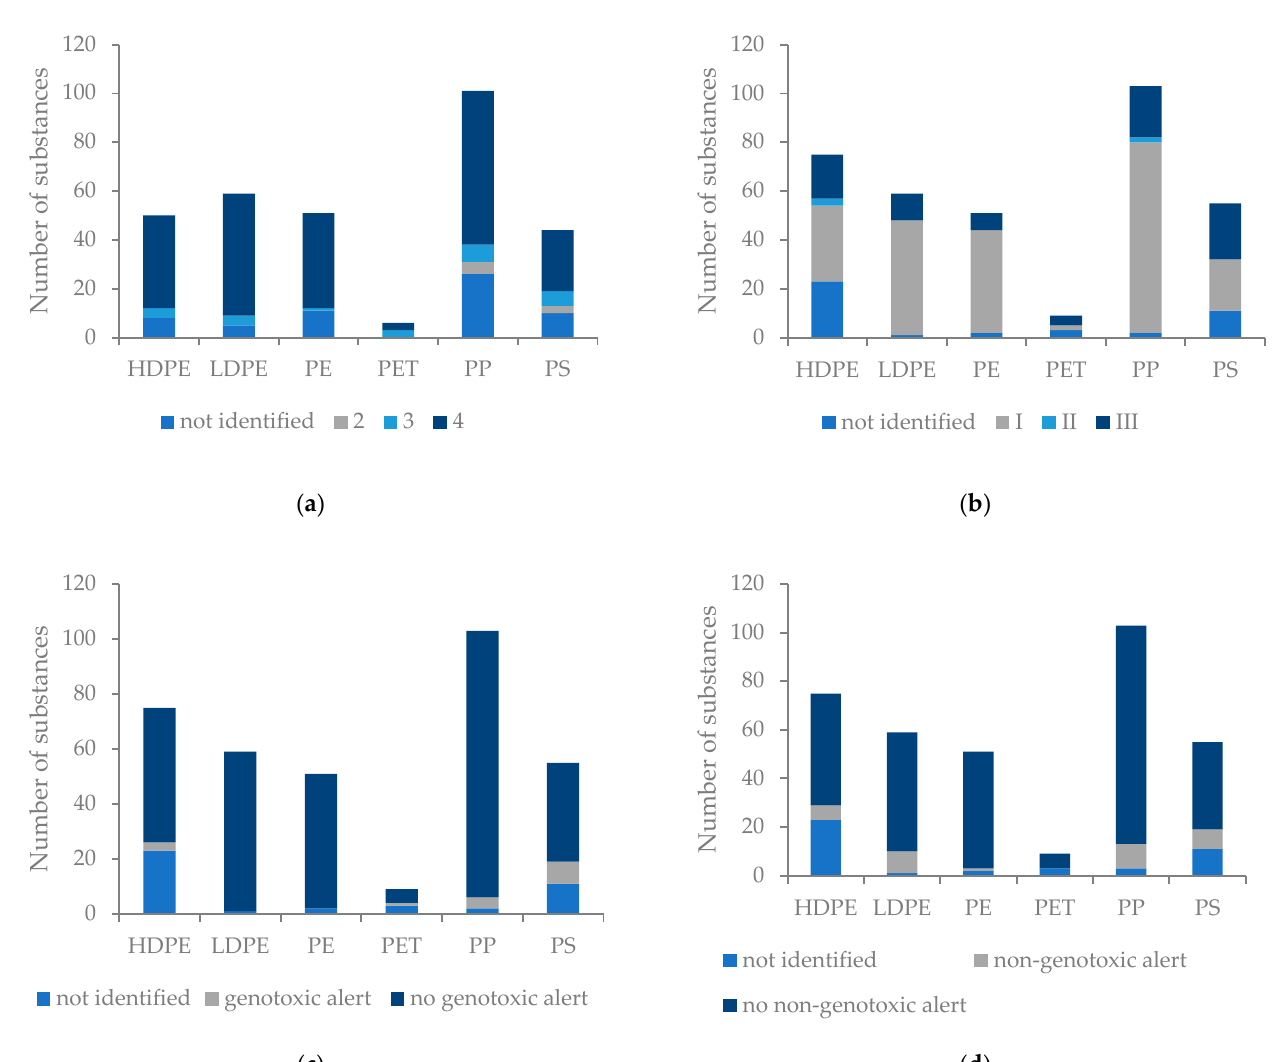
Figure 2. Bar plots with ( a ) the no. of substances from each log P class for each polymer, class 1: log P = 0–1, class 2: log P = 1–2, class 3: log P = 2–4, class 4: log P ≥ 4; ( b ) the no. of substances for each Cramer class; ( c ) no. of substances with gtc alerts; ( d ) no. of substances with ngtc alerts.